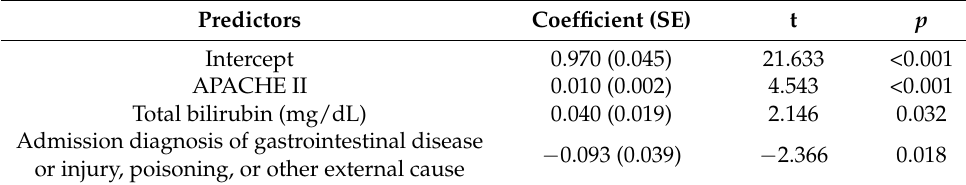
Table 5. Multiple linear regression analysis to identify predictors for ICU length of